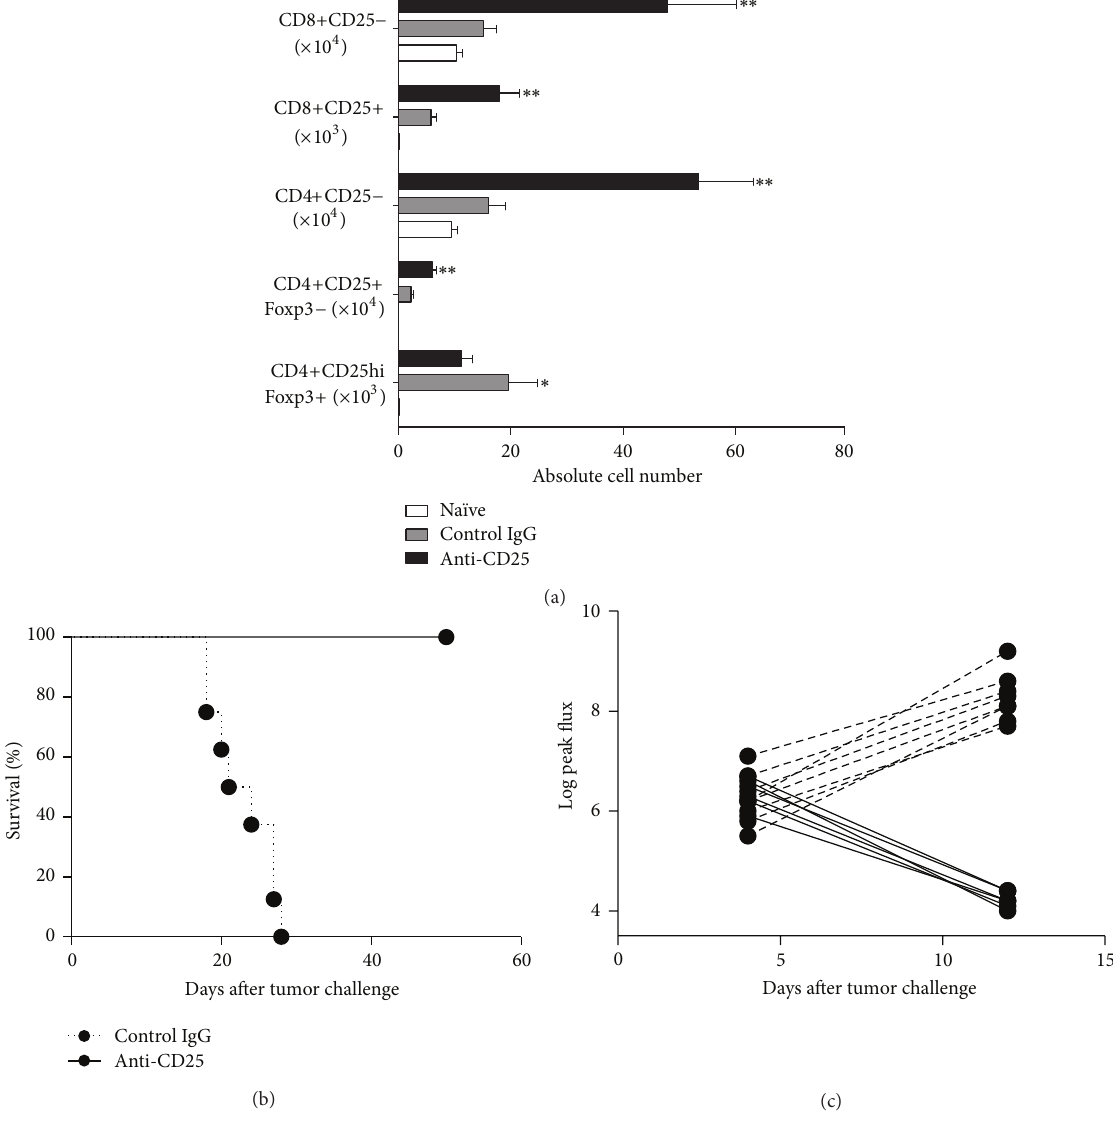
Figure 1: PC61 treatment specifically eliminates brain-infiltrating CD4+CD25hiFoxp3+ Treg. (a) Two weeks after tumor challenge, animals that were either prophylactically treated with PC61 anti-CD25 mAb (black bars, 𝑛 = 11 ) or with control rat IgG (grey bars, 𝑛 = 5 ) were sacrificed, and the brain-infiltrating CD4+ and CD8+ lymphocytes were analyzed by flow cytometry for expression of CD25 and Foxp3. Results are presented as absolute numbers. (b) Kaplan-Meier survival graph with PC61-treated mice (solid line, 𝑛 = 9 ) and rat IgG control mice (dotted line, 𝑛 = 8 ). Mice were tumor challenged on day 0. In one experiment, mice were challenged with Fluc-transduced GL261 cells. (c) Tumor burden was assessed through bioluminescence imaging on days 4 and 12 after tumor challenge of both PC61-treated mice (solid lines, 𝑛 = 6 ) and control IgG-treated mice (dashed lines, 𝑛 = 8 ). Data are presented as LOG (peak